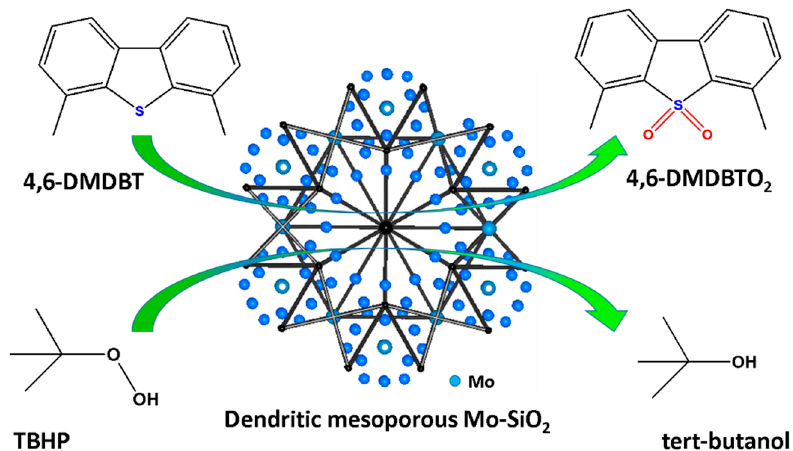
Figure 2. Schematic representation of dendritic mesoporous Mo-SiO 2 catalyst and its desulfurization mechanism [91].